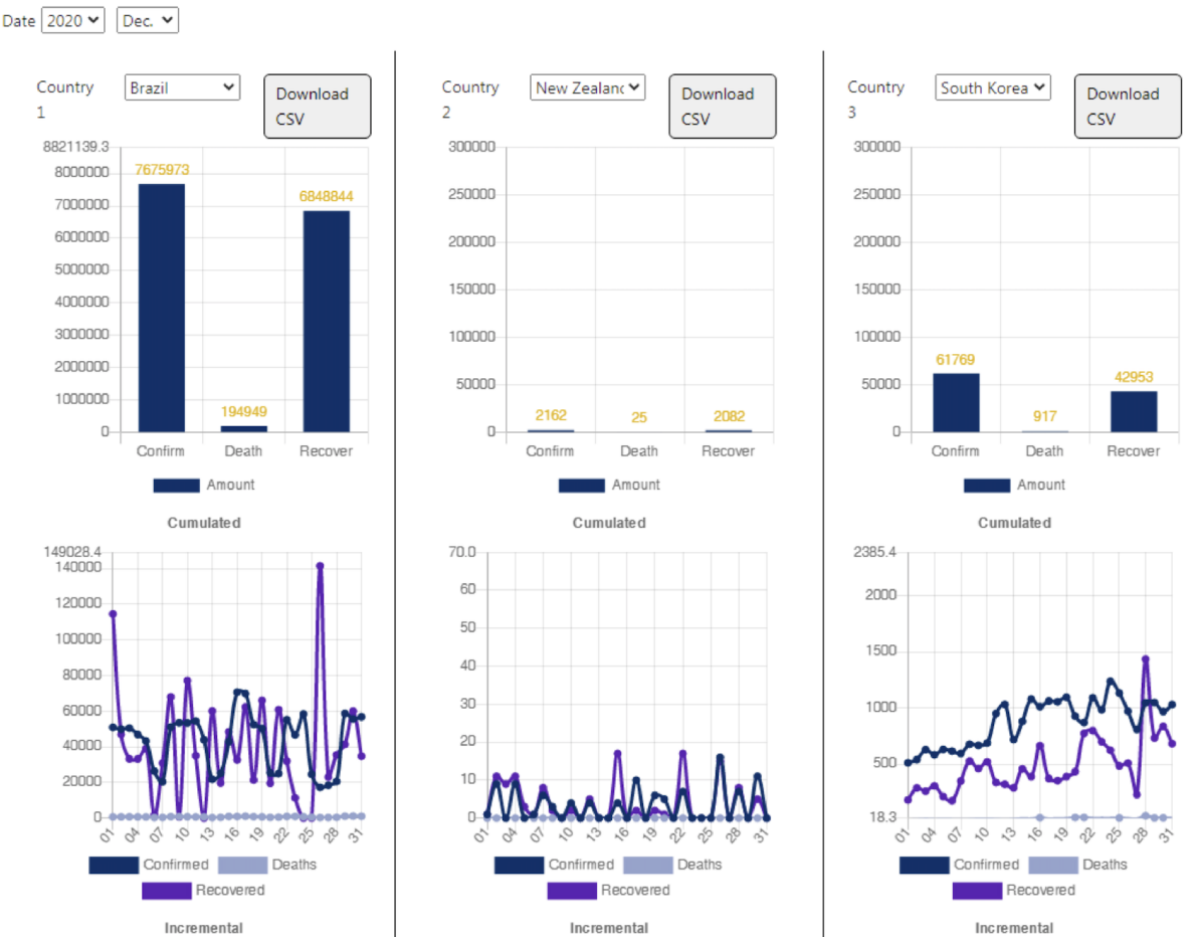
Figure 4. The interface of descriptive statistics for selected countries with customization on the COVID-19 Pandemic AI System (CPAIS) website. CSV: comma-separated